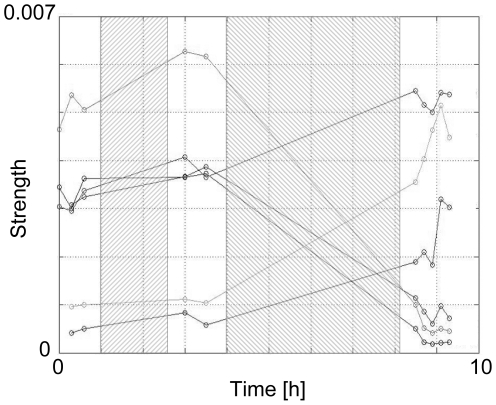
Strengths of persisting connections during one of our experiments.In this experiment there were only 6 persisting functional connections and the development of their strengths is represented by the 6 lines. The experiments had 5 phases. White areas: spontaneous activity recordings. left hatched area: random stimulation (see section II.B). Right hatched area: training protocol (see section II.C). The graphs illustrate that the strength of most individual connections was affected by the protocol. In total, the strength of 64% of all persisting connections was significantly changed. The figure also suggests that global parameters like mean strength may not be affected by the protocol.